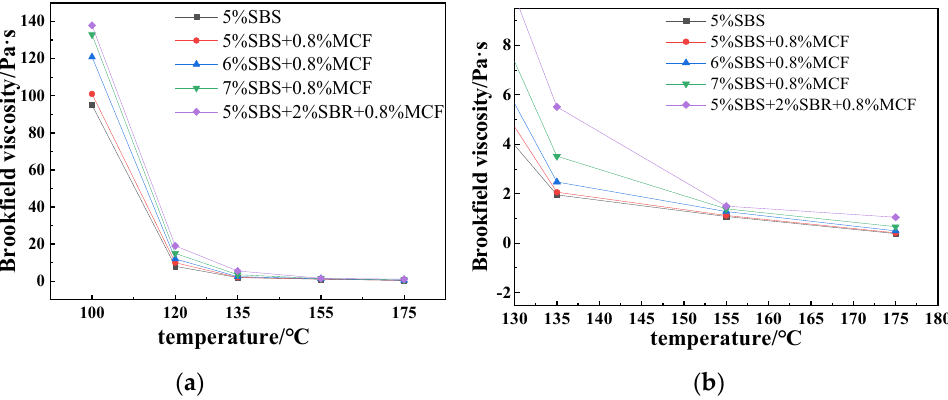
Figure 6. Rotational viscosity test results for the modified asphalts. ( a ) 100–175 °C temperature range; ( b ) 130–175 °C temperature range.